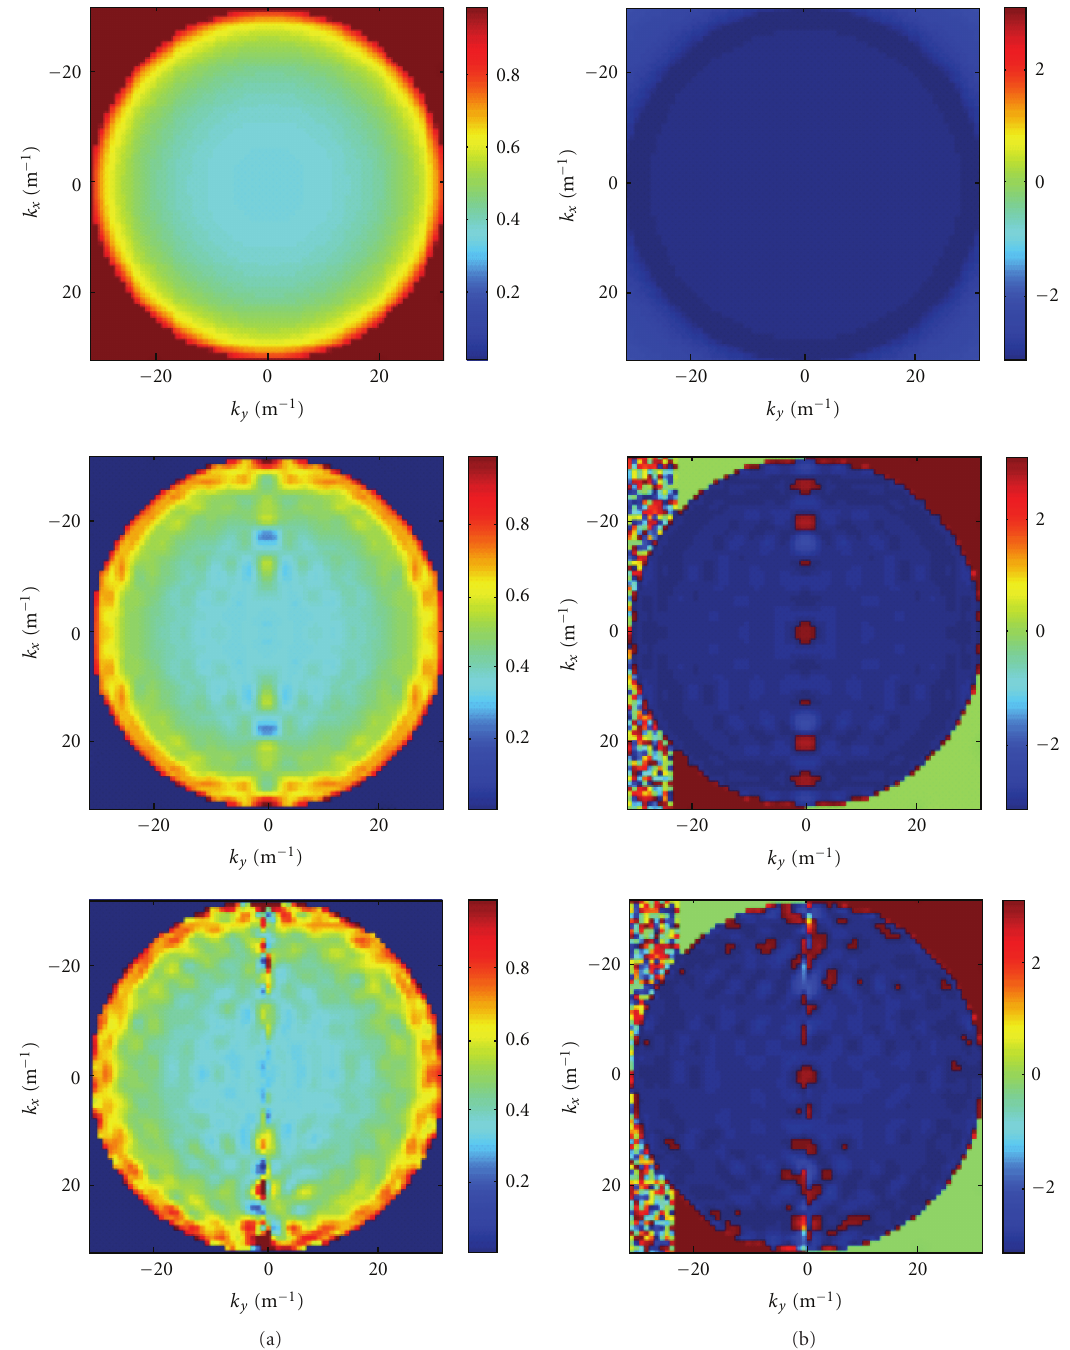
Figure 8: Soil 3. Amplitude (a) and phase (b) of Γ TE . Top line: actual values; middle line: noiseless estimation; bottom line: noisy